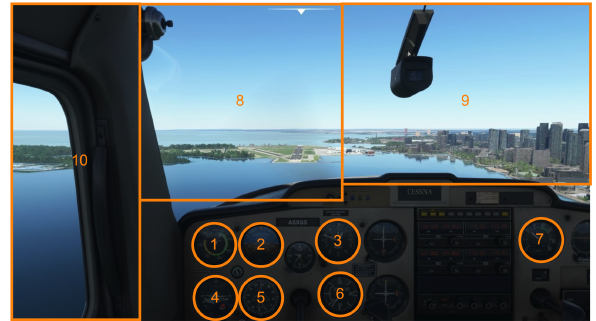
Figure 1. Illustration of the visual stimuli employed in the Microsoft Flight Simulator landing challenge environment. The participants point of view of the cockpit replicated that of a pilot flying a Cessna 152, pre-set for a straight-on approach to Billy Bishop airport, Toronto, Canada. The orange boxes represent the ten main areas of interest used in the gaze analyses. These include the airspeed (1), attitude (2), altimeter (3), turn coordinator (4), heading (5), vertical speed (6) and power (7) indicators, as well as the runway (8), horizon (9), and side window